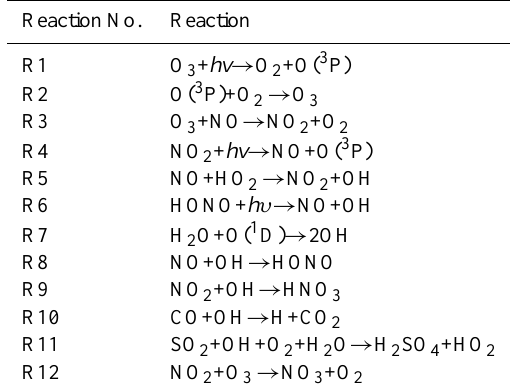
Table 4. Gas phase reaction indices. Reaction No.